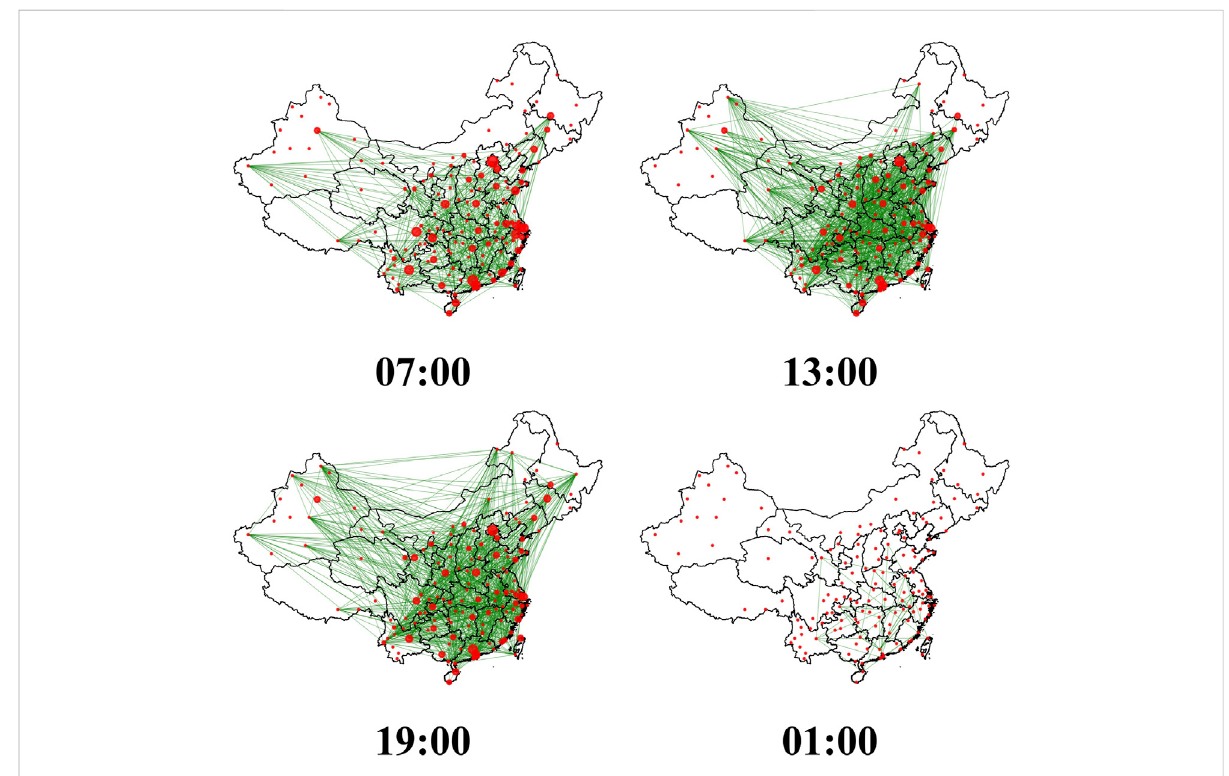
FIGURE 2 Snapshots of the delay propagation